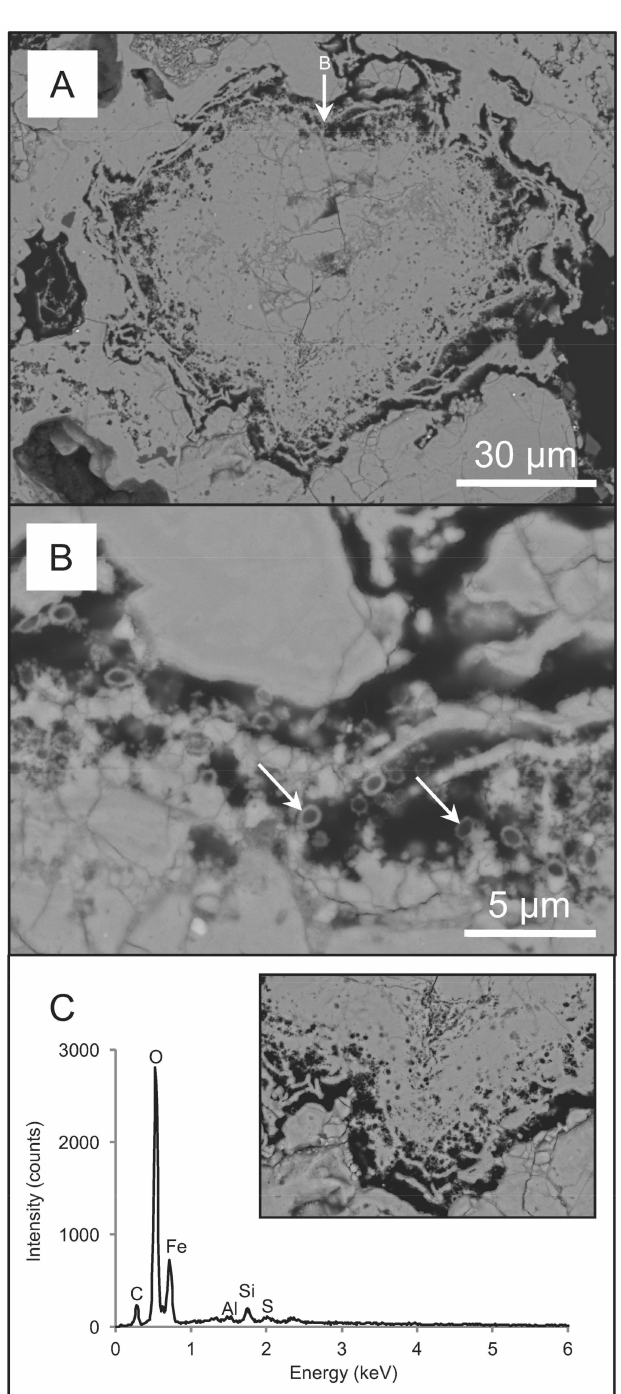
Figure 3. A low-resolution BSC SEM micrograph of a crevice containing an abundance of hollow, circular and oval-shaped structures ( A ); a high-resolution BSC SEM micrograph of these structures that were interpreted as microbial microfossils that once comprised a biofilm within the crevices of gossan ( B ); a representative EDS spectrum identifying the elemental composition of the region containing microfossils ( C ,